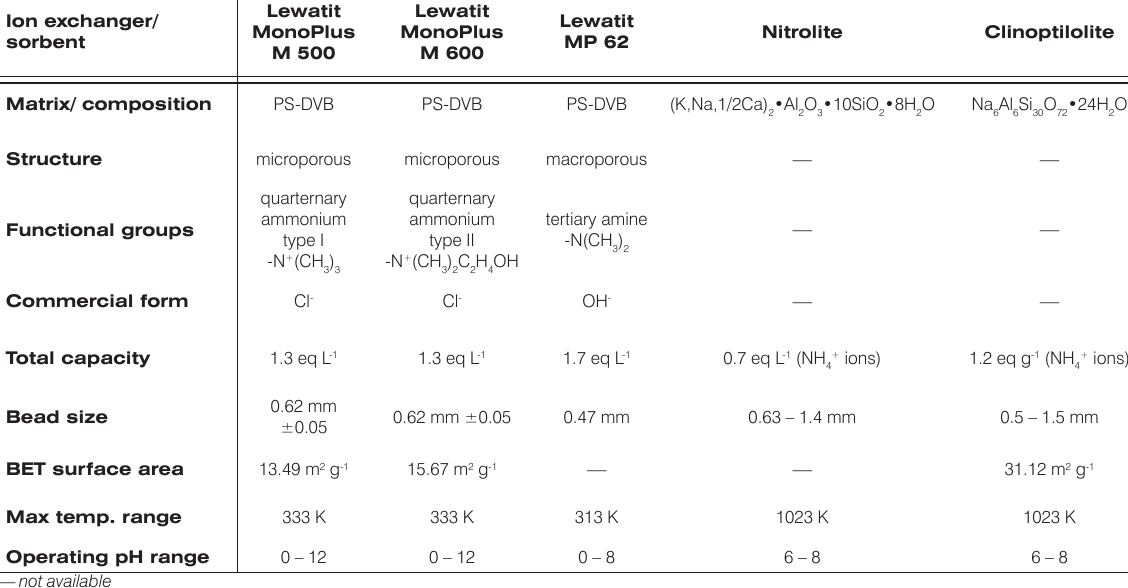
Table 1. Characteristics of anion exchangers and